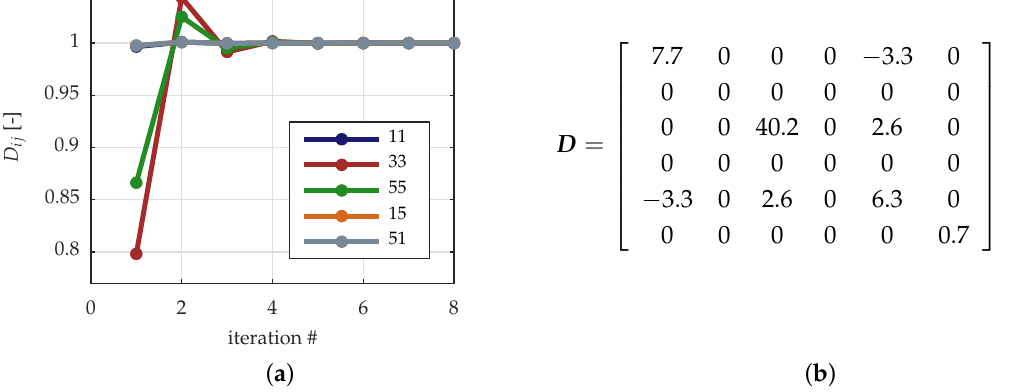
Figure 6. ( a ) iterative solution of Morison drag coefficient matrix D for all relevant indices i , j for aligned wind and waves (scaled model of [39], LC 7) and ( b ) obtained generalized damping matrix.